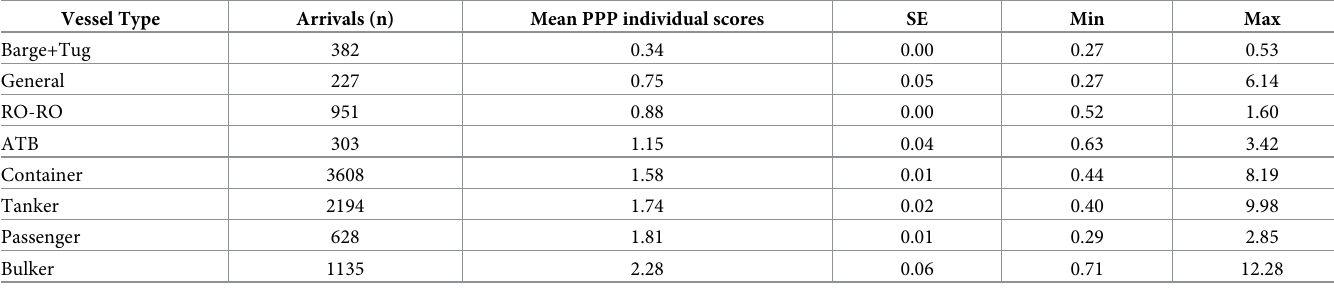
Table 2. Potential propagule pressure